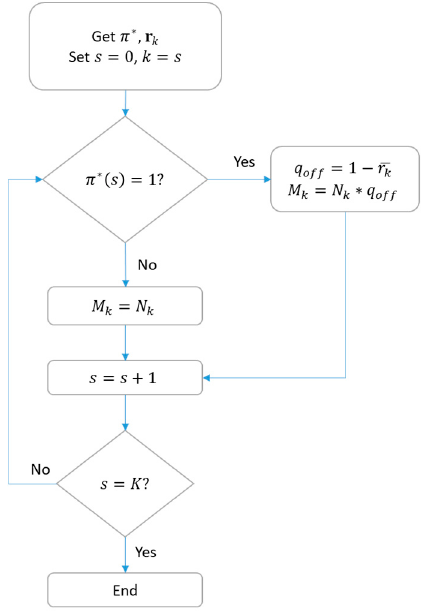
Figure 5. Algorithm for the traffic offloading decision.